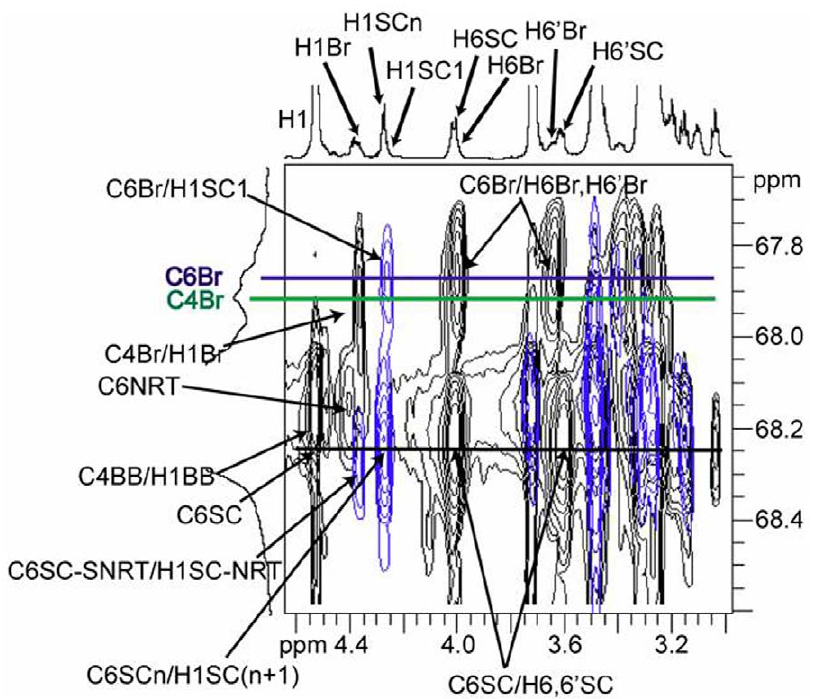
Figure 4. 2D NMR spectra show linkage between branchpoint and the first side chain repeat unit of the (1 R 3,1 R 6)- b -D-glucan isolated from C.glabrataace2 strain. Overlay of the 2D HSQC-TOCSY (black) and HMBC (blue) NMR spectra expanded around the C4 spectral region shows the correlation (C6Br/H1SC1) across the glycosidic link between C6Br of the branchpoint repeat unit and the anomeric proton (H1SC1) of the first (1 R 6)- b -linked repeat unit in the side chain as well as correlations across other (1 R 6)- b -linked side chain glycosidic linkages.